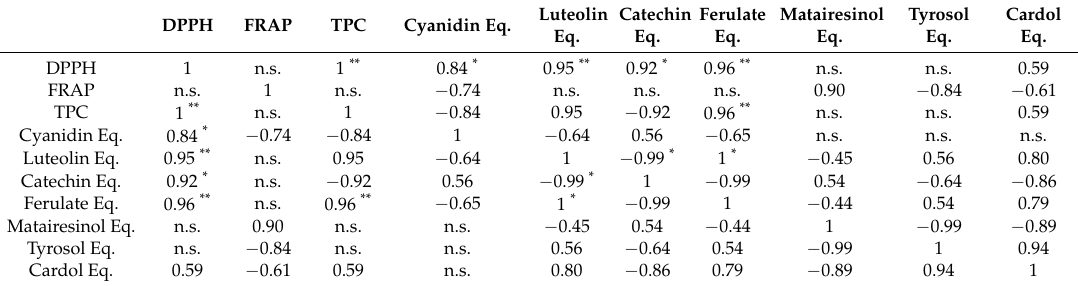
Table 4. Pearson’s correlations coefficients between total phenolic content (TPC), DPPH radical scavenging, FRAP reducing power and phenolic subclasses equivalents. ** = p < 0.01; * = p < 0.05; n.s. = not significant. DPPH